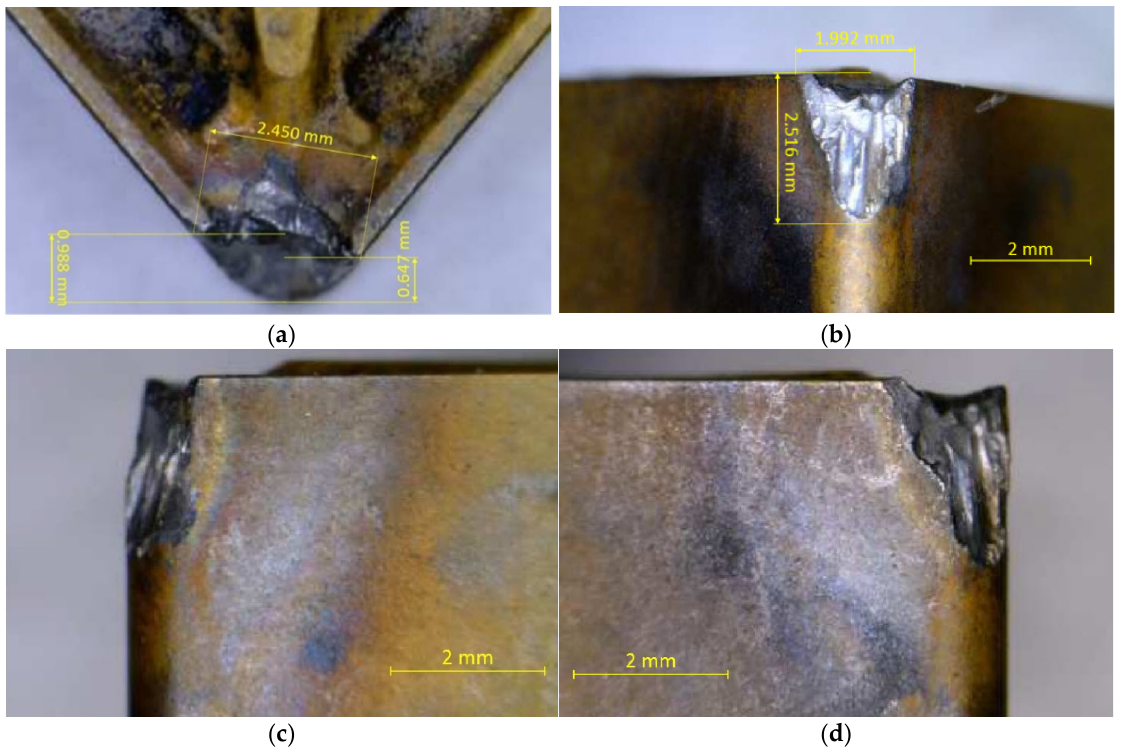
Figure 8. Cutting edges after machining the hardened samples. ( a ) wear of the cutting tip; ( b ) depth of wear of the cutting tip; ( c ) view to the major flank; ( d ) view to the minor flank.